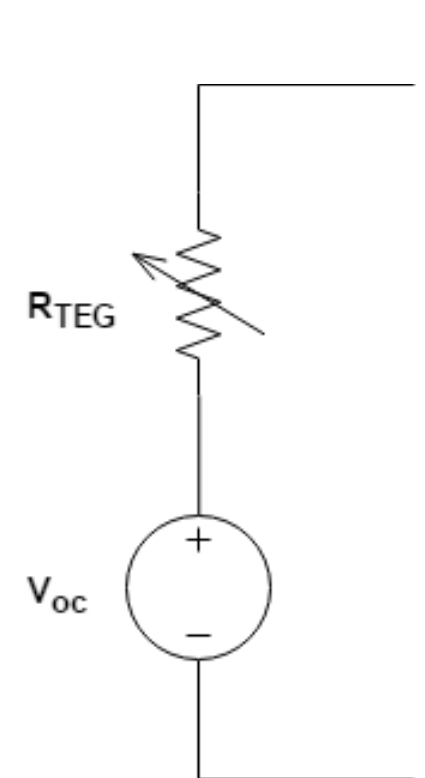
Figure 2. Thermoelectric generator equivalent circuit